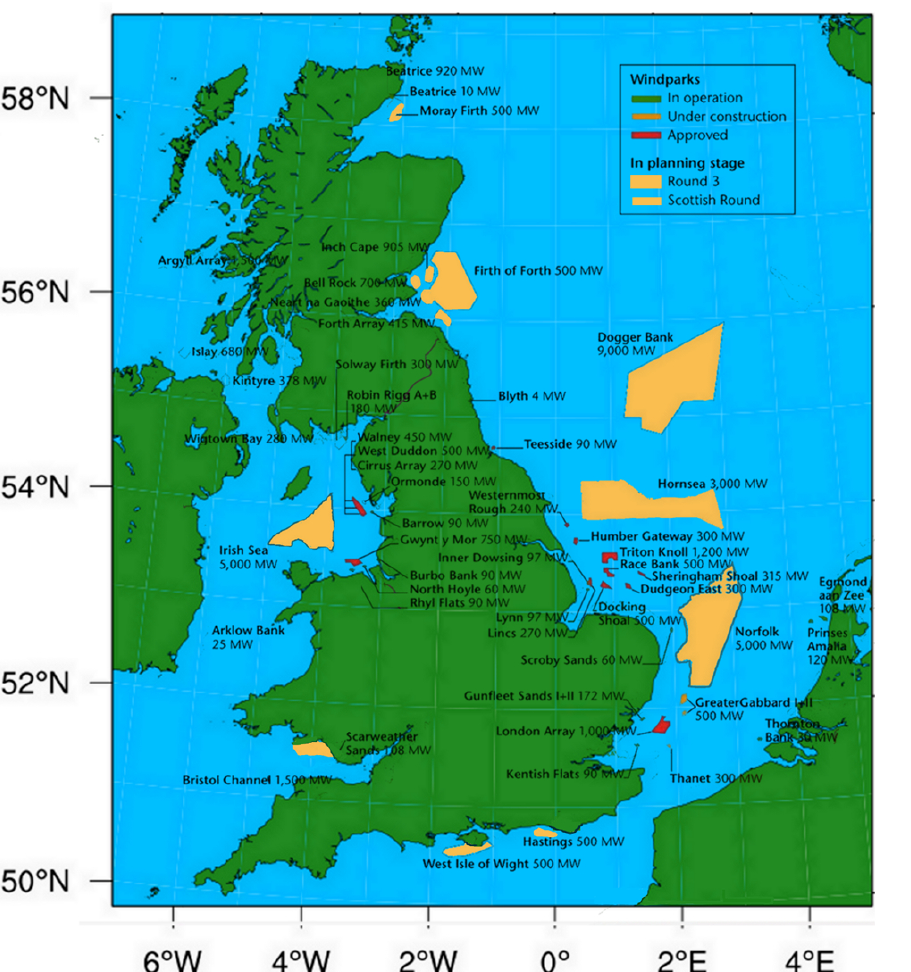
Fig. 3. The locations of constructed or planned offshore wind farms in the UK (Map adapted from Cleantech,